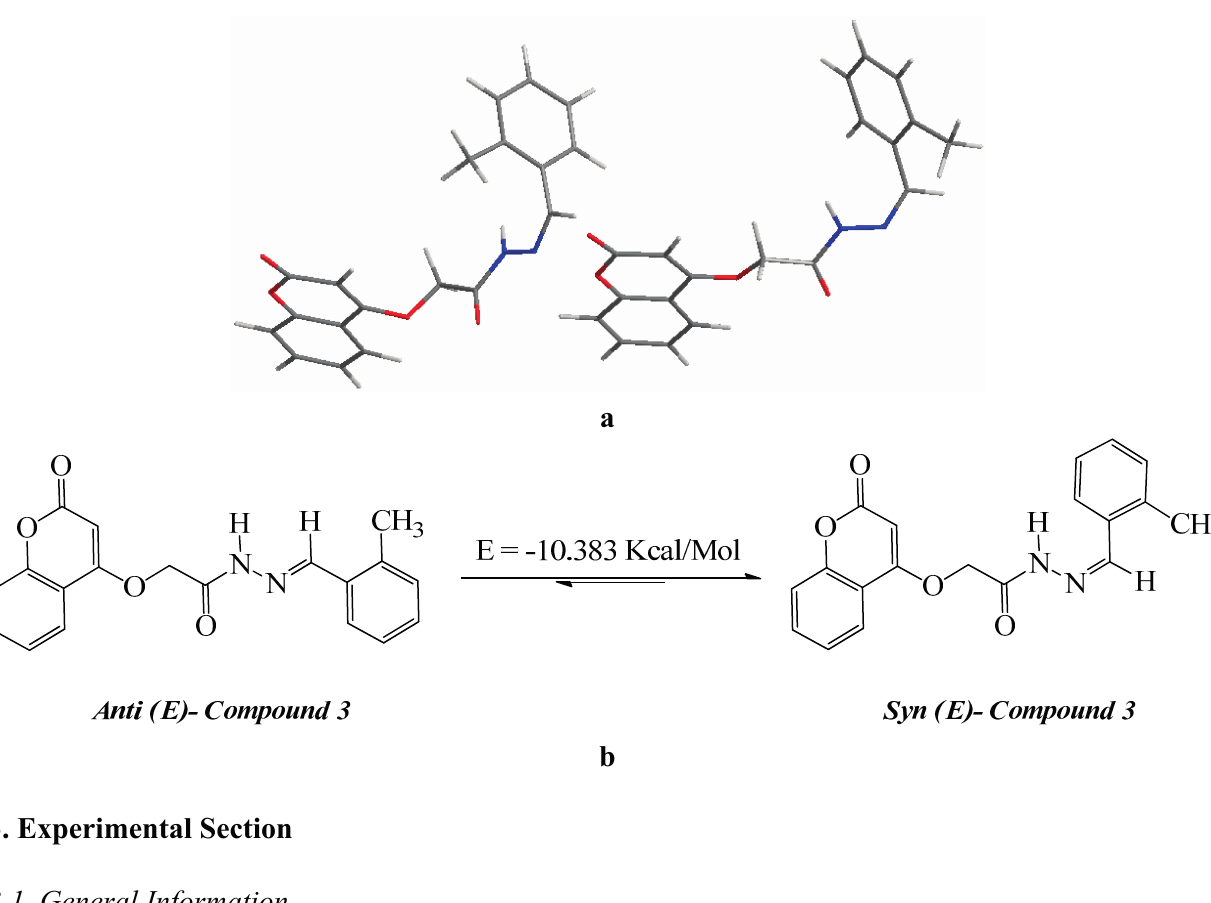
Figure 1. Probable conformational isomers of the N -acylhydrazone of compound 3 . ( a ) = 3dimetional structures; ( b ) = geometrical Isomers)